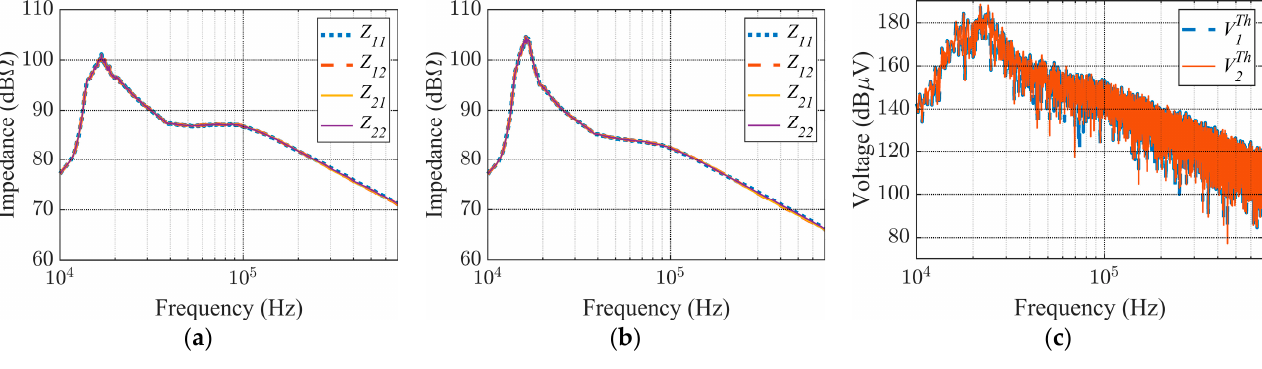
Figure 12. Behavioral model parameters: impedances of ( a ) the PLC Tx modem and ( b ) the PLC Rx modem together with the transmission line; and ( c ) equivalent voltage sources.